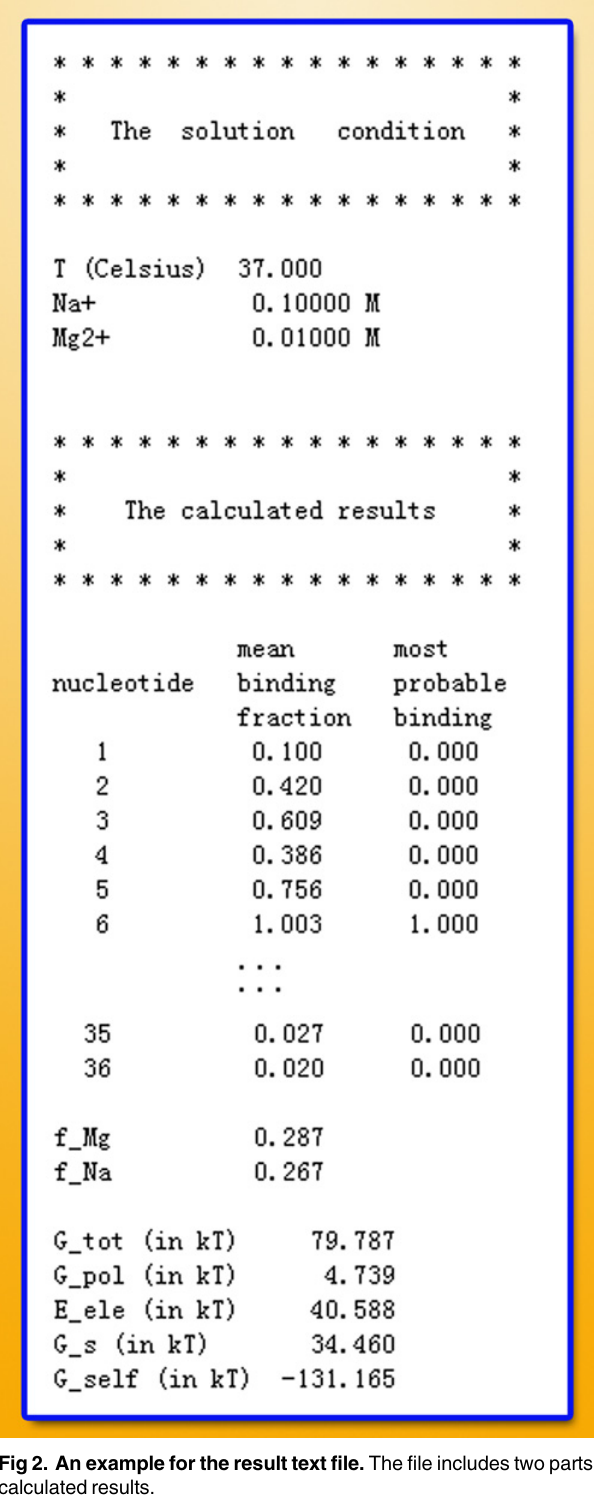
Fig 2. An example for the result text file. The file includes two parts: the solution condition and the calculated results.